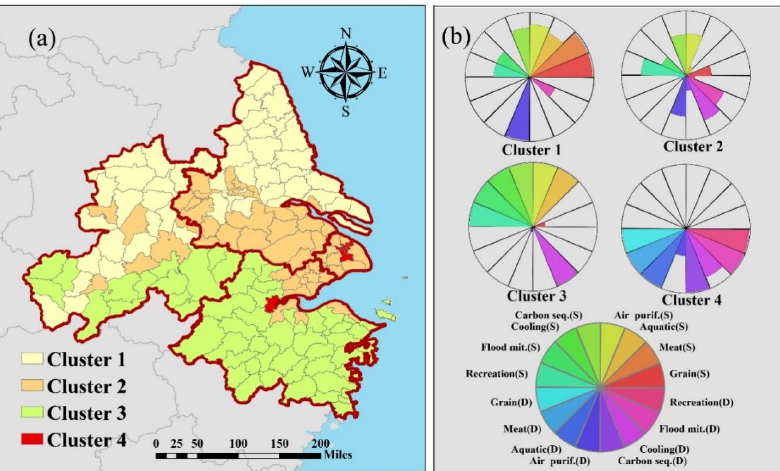
Figure 8. Spatial distribution of ES supply–demand bundles ( a ) and flower diagrams for each identified cluster ( b